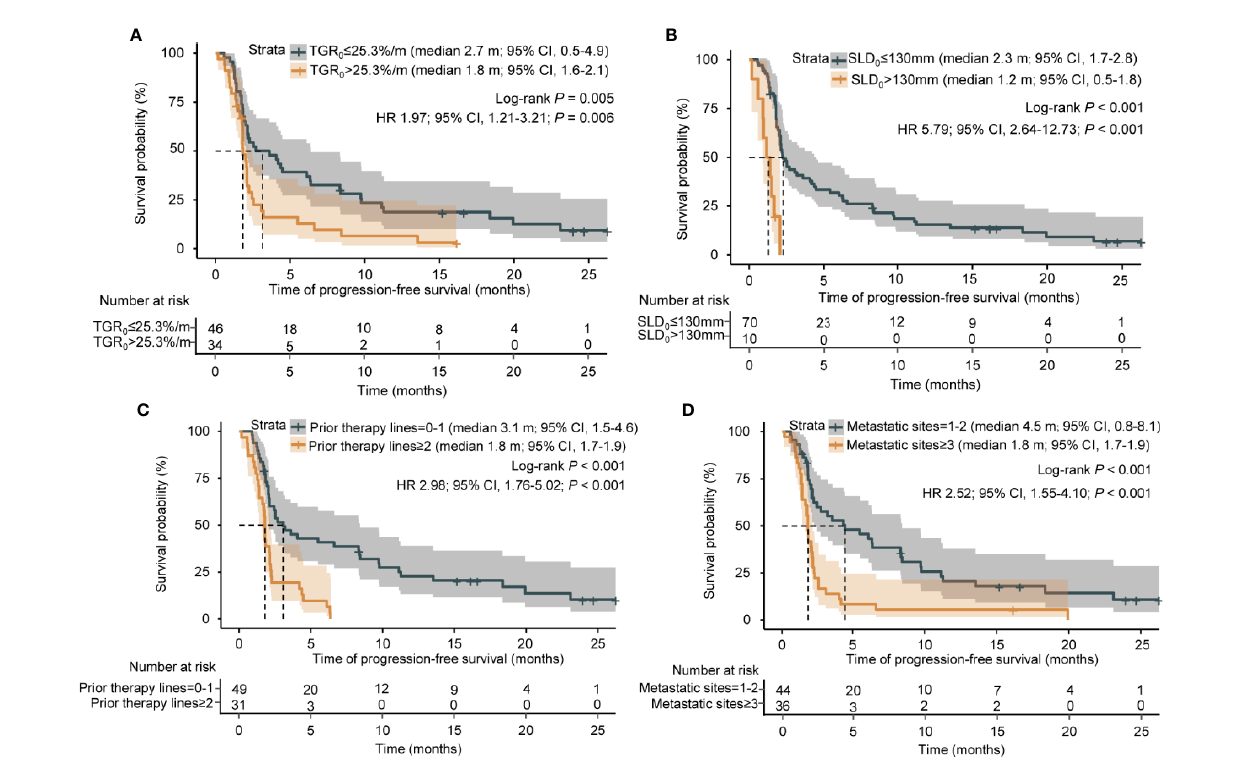
FIGURE 4 | Kaplan-Meier analysis of progression-free survival. (A) Progression-free survival by pre-treatment tumor growth rate. (B) Progression-free survival by sum of the longest diameters of the target lesions at baseline. (C) Progression-free survival by number of prior therapy lines. (D) Progression-free survival by number of metastatic